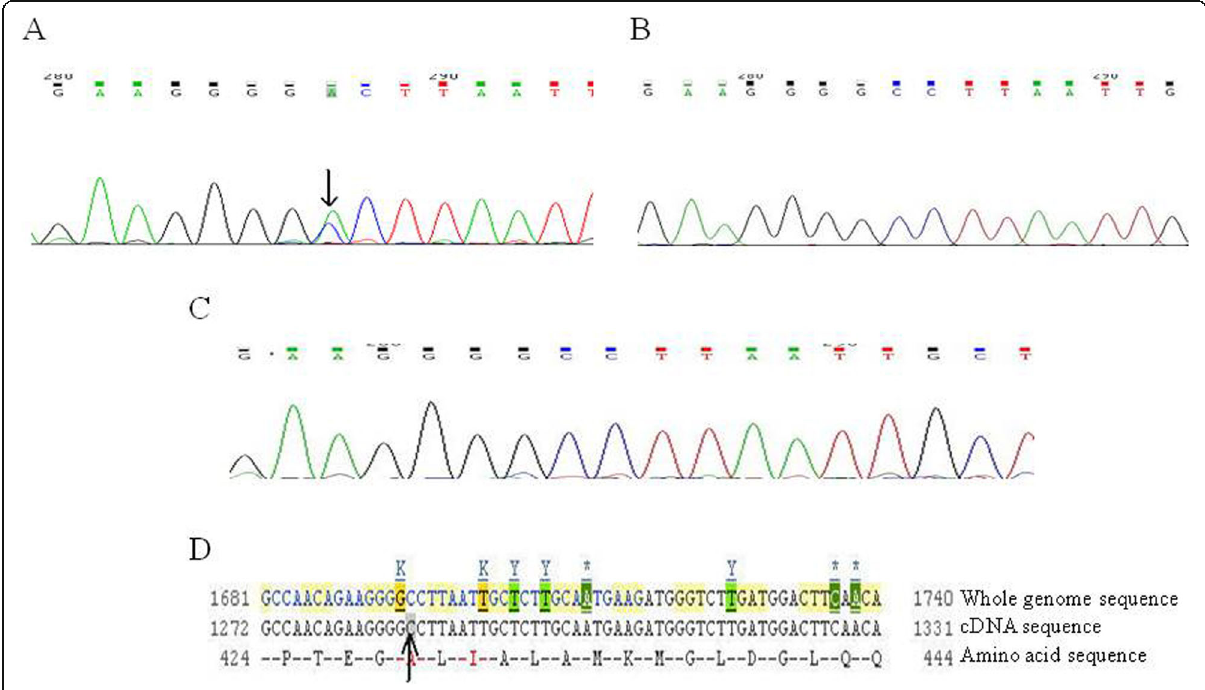
Fig. 4 Exon 15 sequencing for the ATP2C1 gene in pedigree II. a Sequencing result of exon 15 for the proband in pedigree II. b Sequencing result of exon 15 for normal member in the same pedigree. c Sequencing result of exon 15 for normal individual who was not blood related. d A missense mutation c.C1286A(Bases C → A) in exon 15 of ATP2C1 gene in the Ensemble database (indicated by